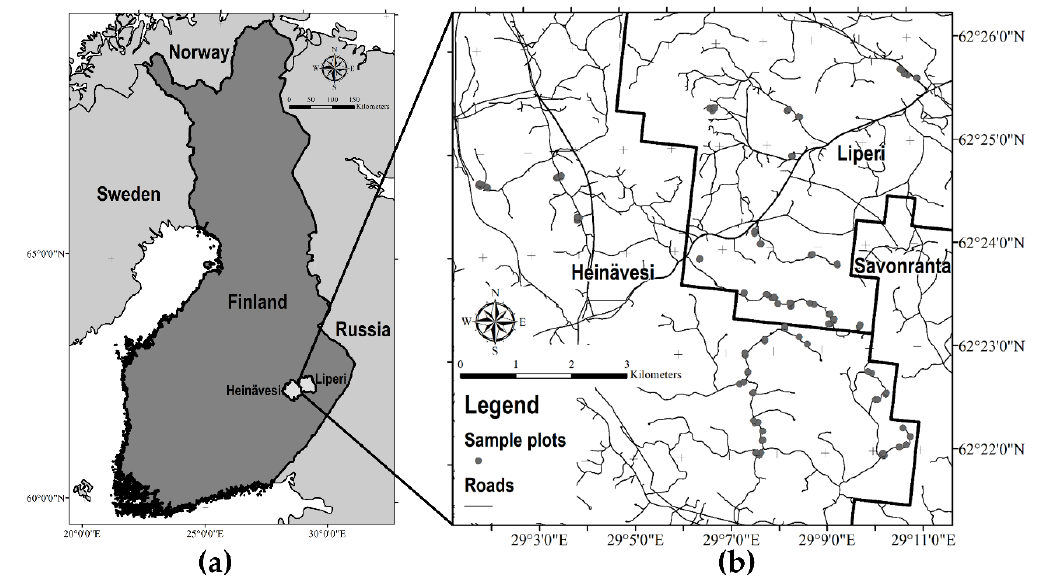
Figure 1. ( a ) Location of Liperi and Heinävesi (light grey) within Finland (dark grey); ( b ) Map of the area in which the sample plots were located.